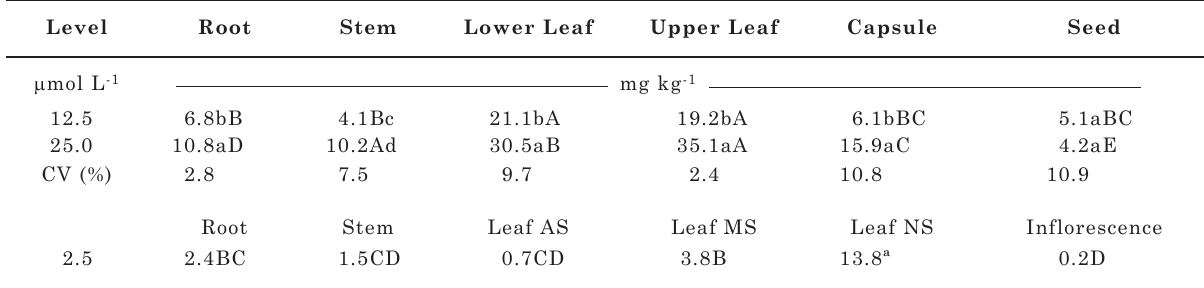
table 3. boron concentration in parts of the castor bean hybrid “iris”, grown in a complete nutrient solution and with levels of